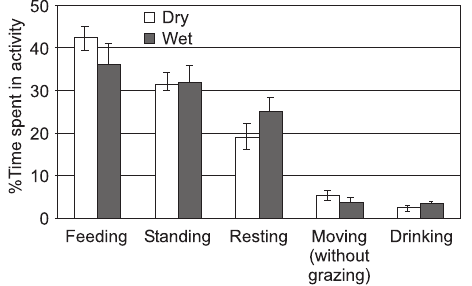
Fig. 3. Relative proportions of time allocated by the buffalo herds to activities, dry season (white) and wet season (black) components, with their standard errors ( SE